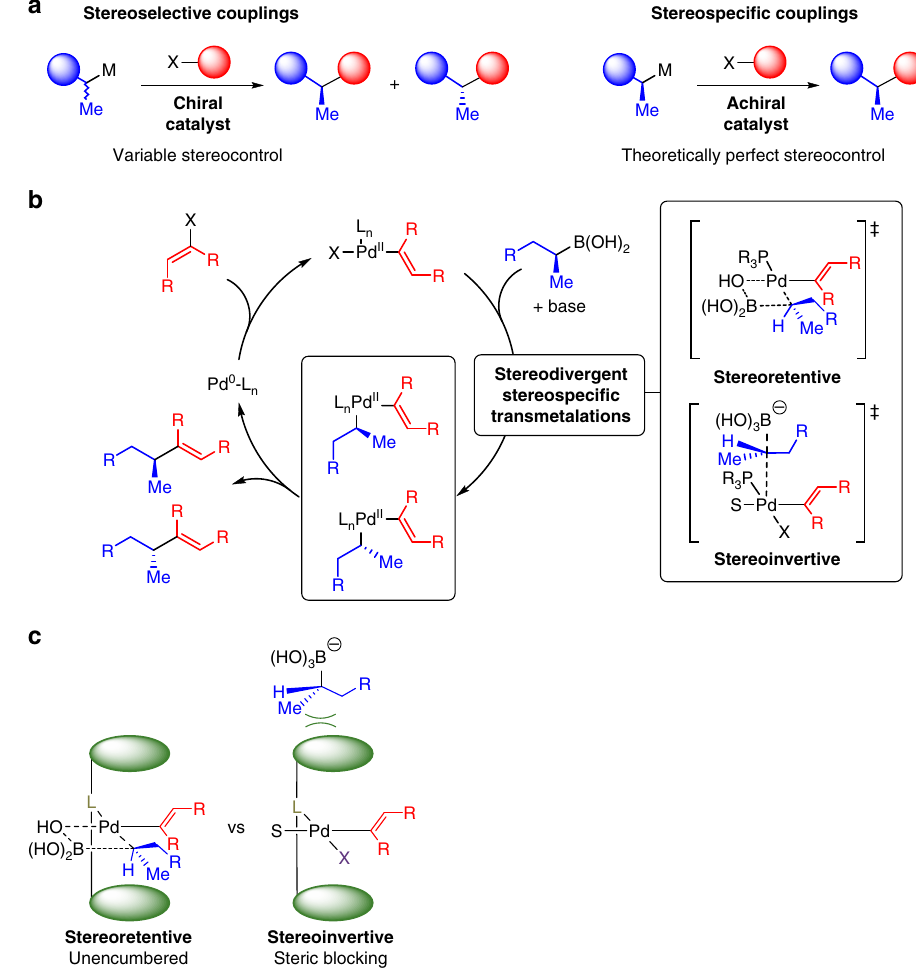
Fig. 1 Challenges in stereocontrolled Csp 3 couplings. a Stereoselective couplings vs. stereospeci fi c couplings. b Competing stereodivergent stereospeci fi c transmetalation pathways. c Axial shielding — a ligand design principle for controlling stereochemistry in Csp 3 couplings. Projecting steric bulk above and below the Pd (II) square plane should selectively inhibit stereoinvertive transmetalation, thus favoring